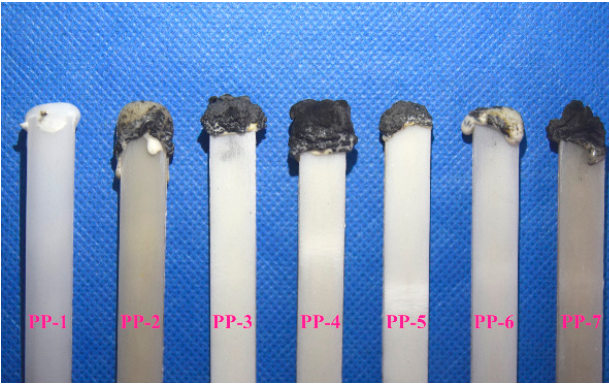
Figure 8. Photos of char residues after LOI test for PP and PP composites.